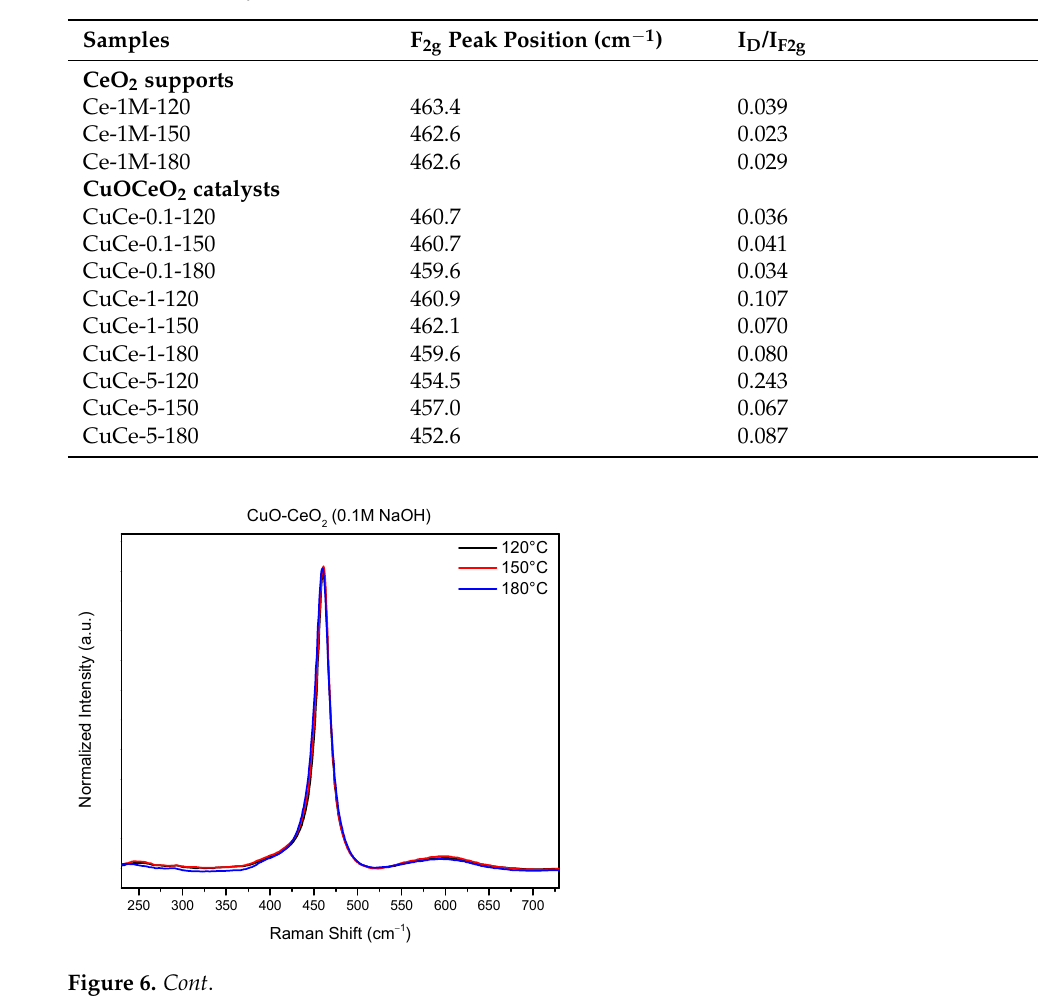
Table 4. Peak position of the F 2g vibration band and the relative amount of oxygen vacancies (I D /I F2g ) of CuOCeO 2 catalysts.